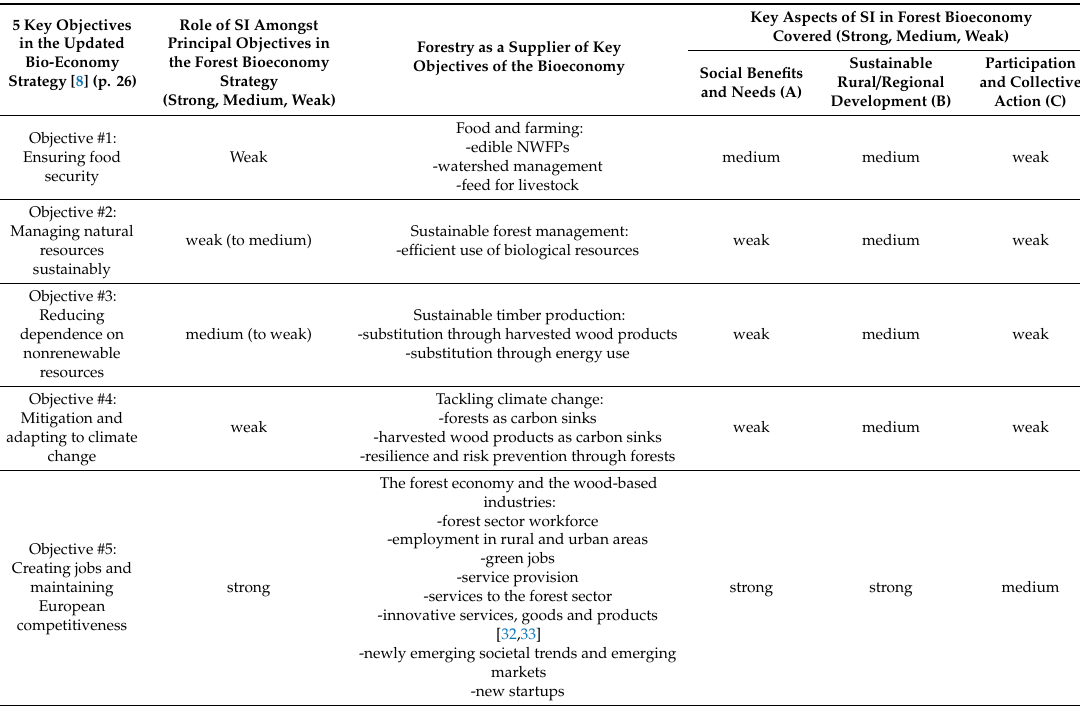
Table 1. The key bioeconomy objectives and related supply functions from forestry. EU Bioeconomy Strategy objectives [8] (p. 26) and rating of key aspects and role of social innovation (according a scale of strong, medium, and